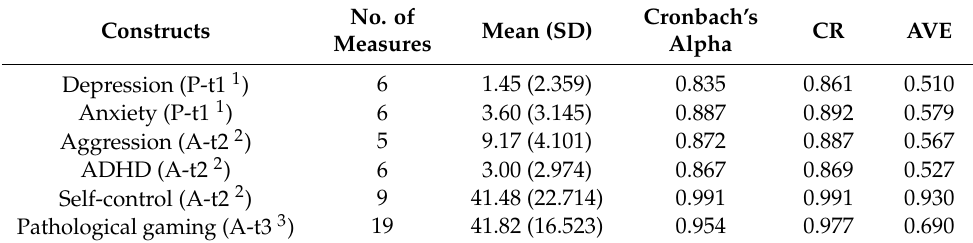
Table 1. Reliability and discriminant validity of constructs.